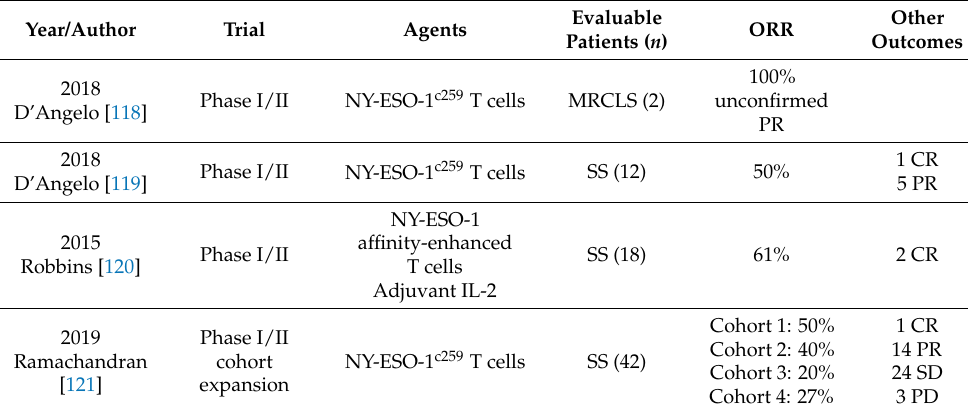
Table 5. Clinical trials exploring the use of ACT in